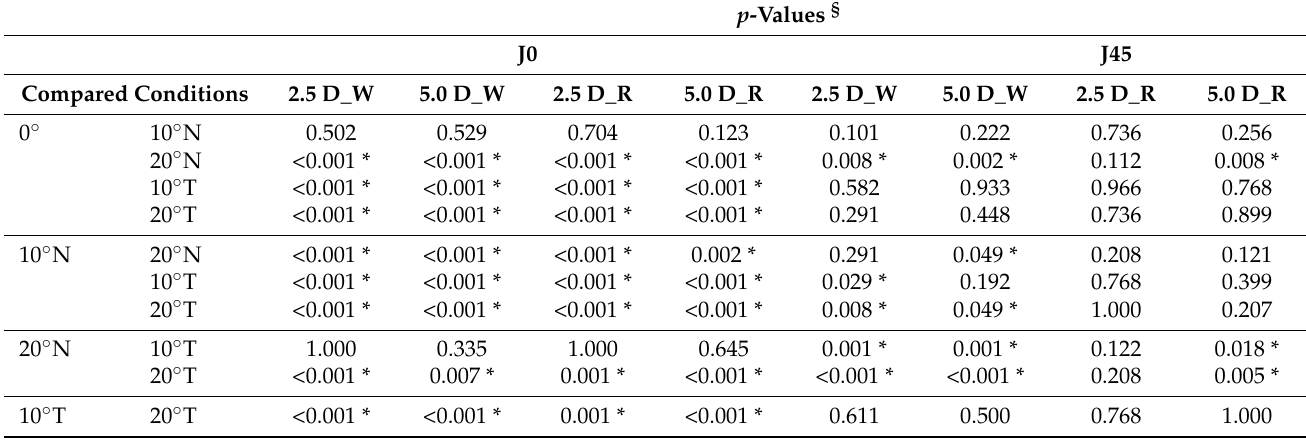
Table 5. Pair-wise differences in astigmatic components J0 and J45 according to eccentricity for each accommodative demand and illumination (R: red; W: